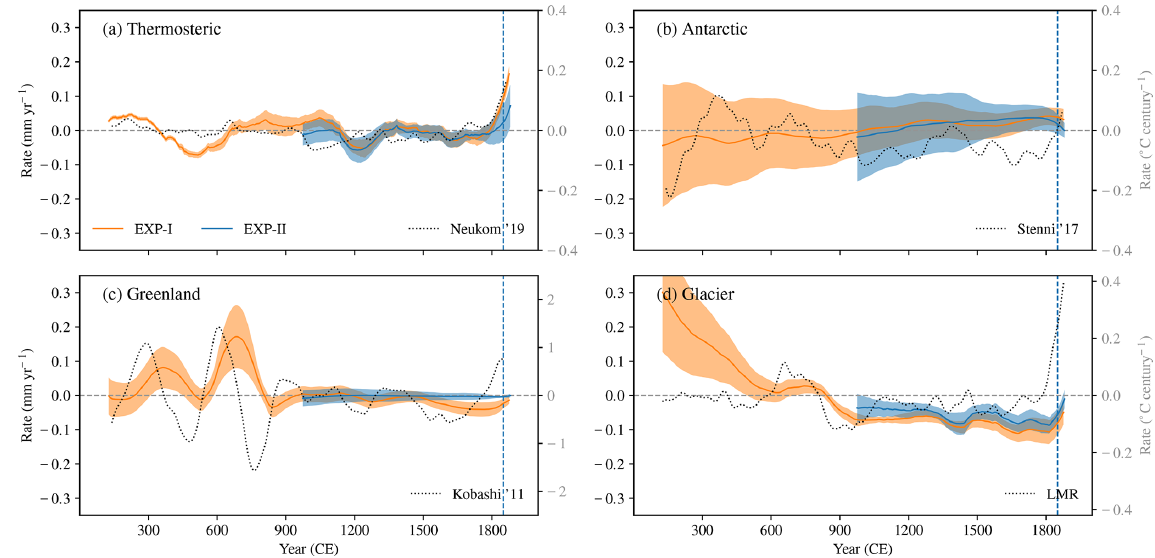
Figure 3. The 250-year moving rate of sea level for each of the components shown in Fig. 2. (a) Thermosteric, (b) Antarctic, (c) Greenland and (d) glaciers mass balance. The 250-year rate of global (a) and regional surface temperature (shown in Fig. 2) is also shown (dotted grey lines). The shading around sea-level rates indicates 1 σ confidence level of the ensemble mean